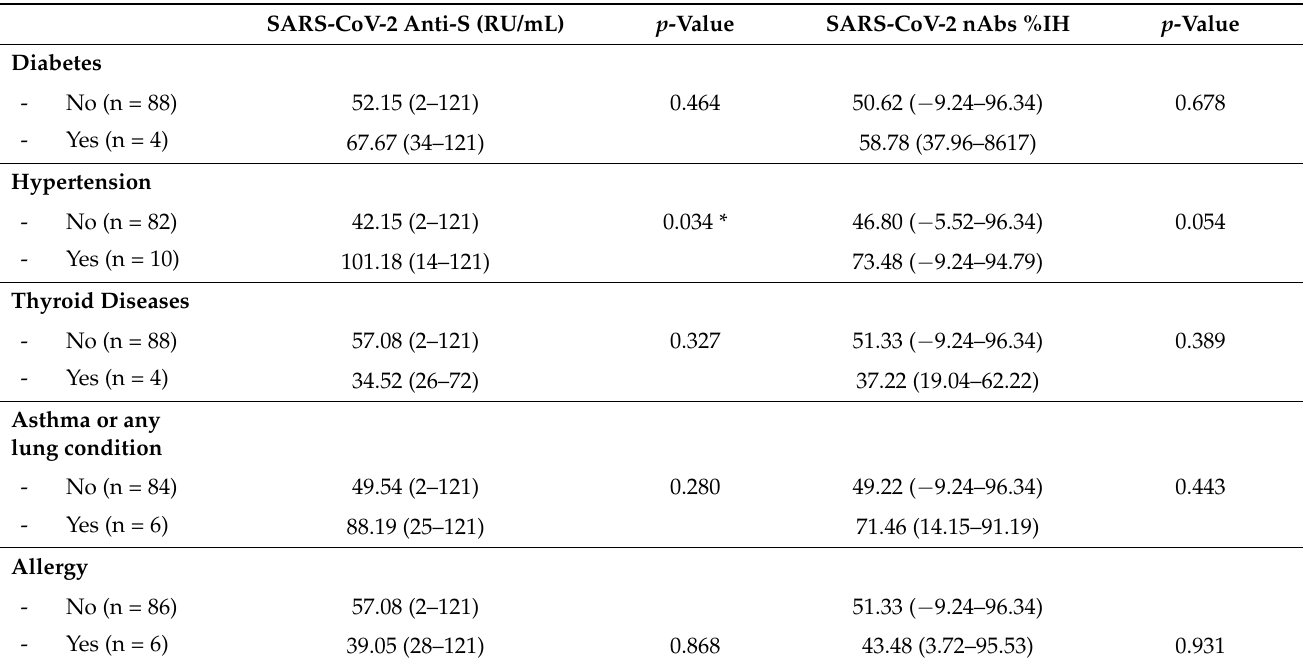
Table 6. Quantitative analysis of SARS-CoV-2 anti-S and %IH of nAbs in relation to the medical history of 92 Sinopharm vaccine